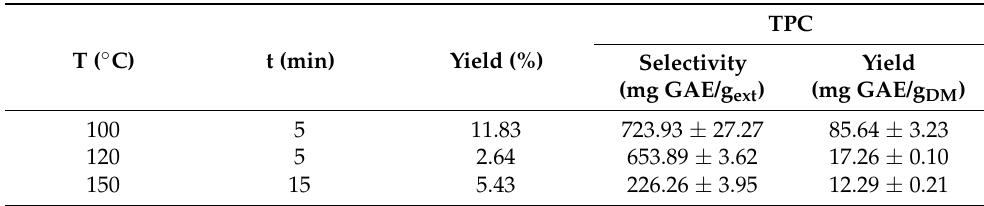
Table 4. Extraction conditions, yield, and TPC of the samples obtained with the process performed at 100 ◦ C, 120 ◦ C, and 150 ◦